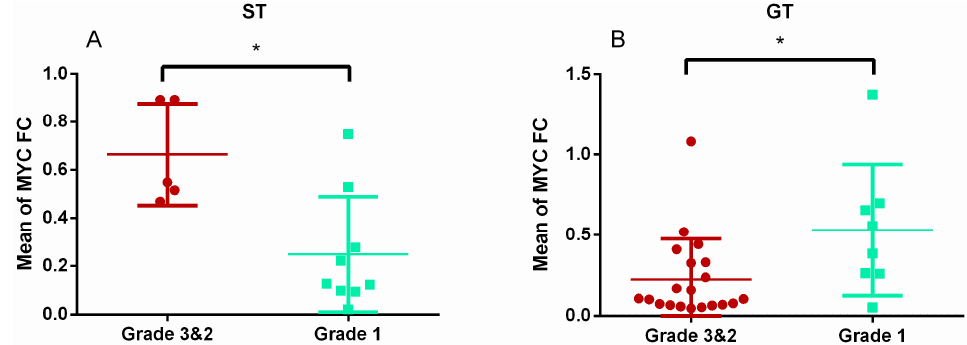
Figure 4. Different expression of MYC depending on invasiveness. MYC fold change values between invasive (grade 3 and 2) and non-invasive (grade 1) tumours in the ST ( A ) and in the GT subtypes ( B ). * Mann–Whitney U, p = 0.018 and p = 0.033, respectively.